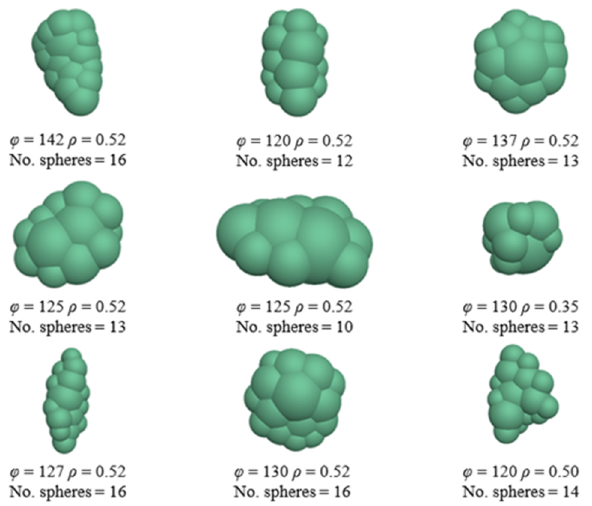
Figure 2. Irregular-shaped particles used in this study and their corresponding parameters.